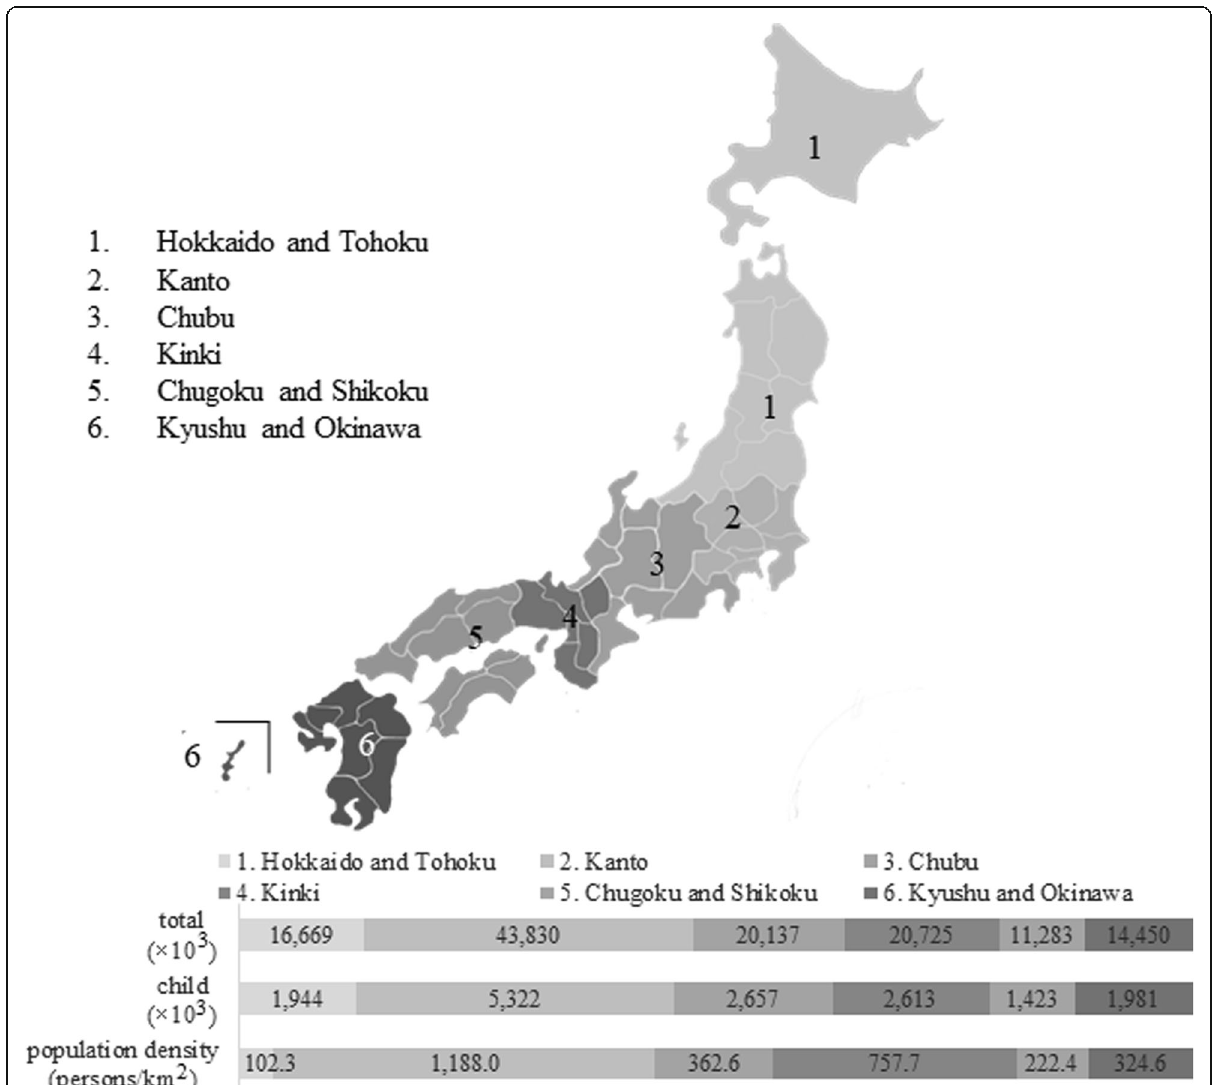
Fig. 2 The six regions in Japan and number of people and children in each area, population by 2015 Population Census